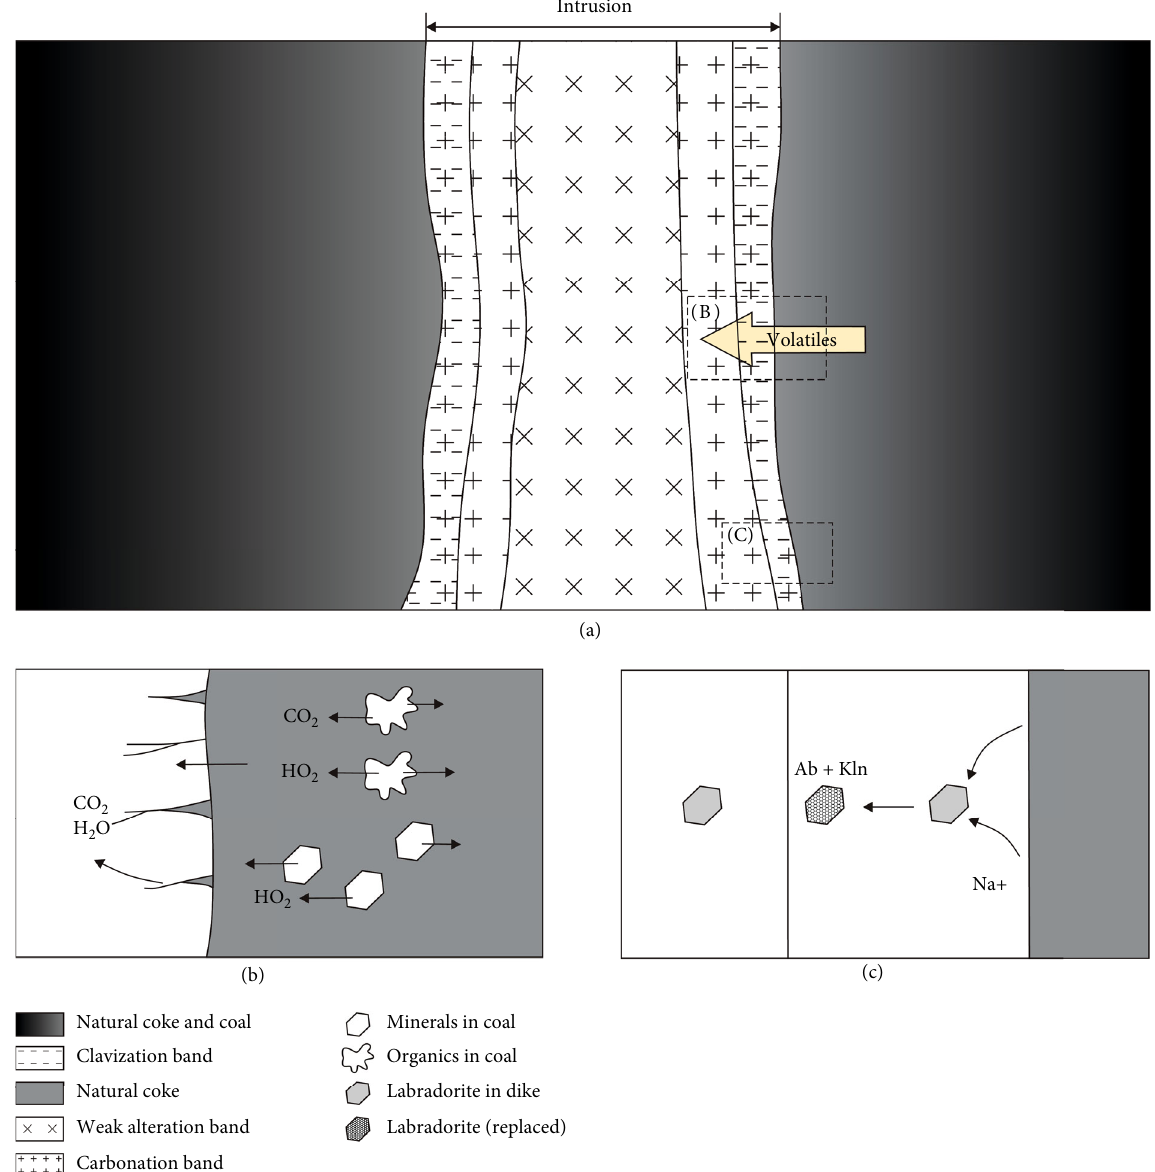
Figure 13: (a) Schematic of the intrusion alteration in the dike. (b) Carbonation of ma fi c minerals when volatiles are released from the organics and minerals in the coal. (c) Albitization of plagioclase. Labradorite is replaced by albite and kaolin group